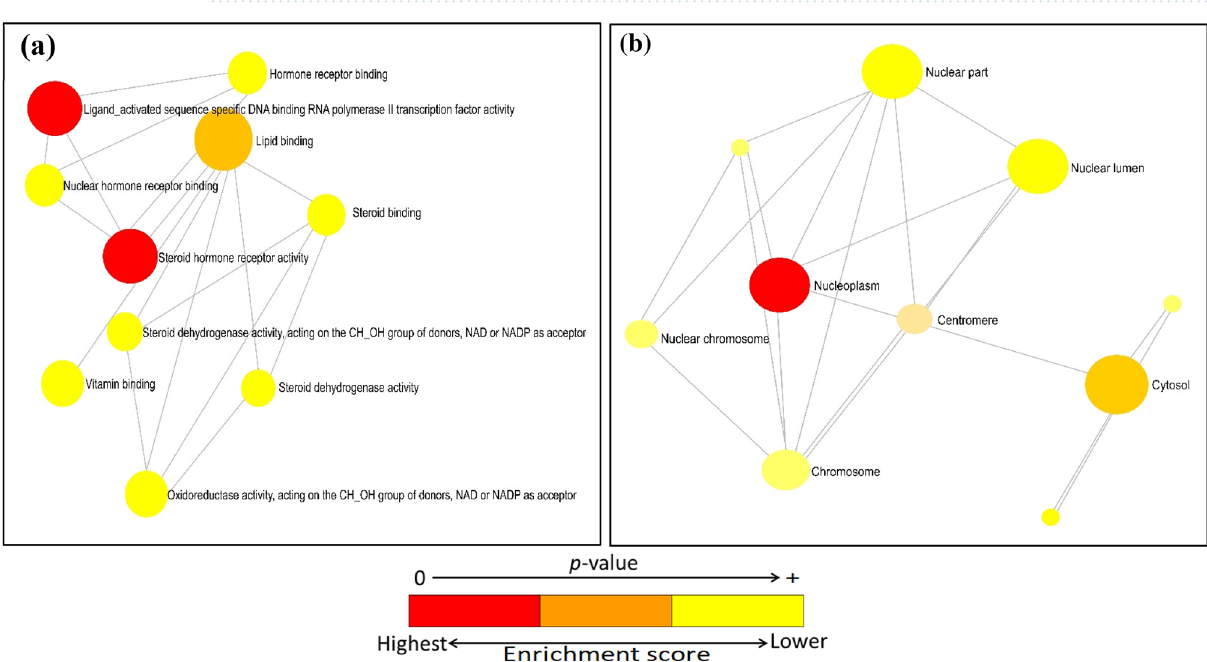
Figure 5. Networks of top ten enriched molecular functions ( a ) and cellular components ( b ) constructed by Network Analyst. In both networks, nodes are color shaded according to their enrichment score (red > orange >